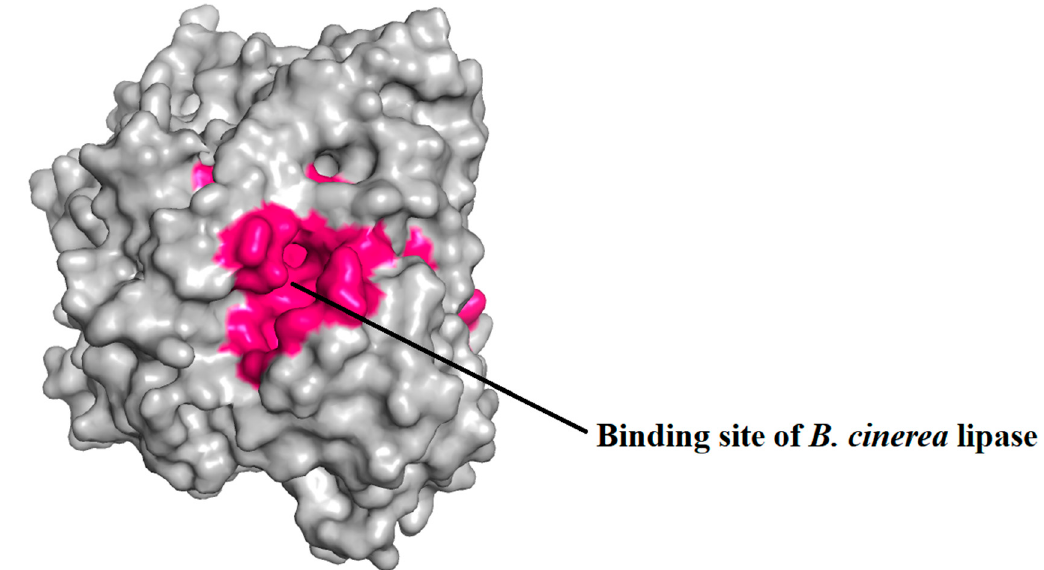
Figure 8. Binding pocket of B. cinerea lipase. Binding pocket of B. cinerea lipase that has been predicted depicted by pink color. The binding pocket is very big and deep, consisting of a large number of amino acid residues.